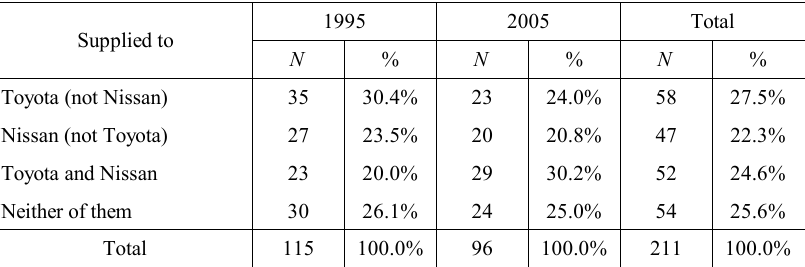
Table 2. Descriptive statistics of the